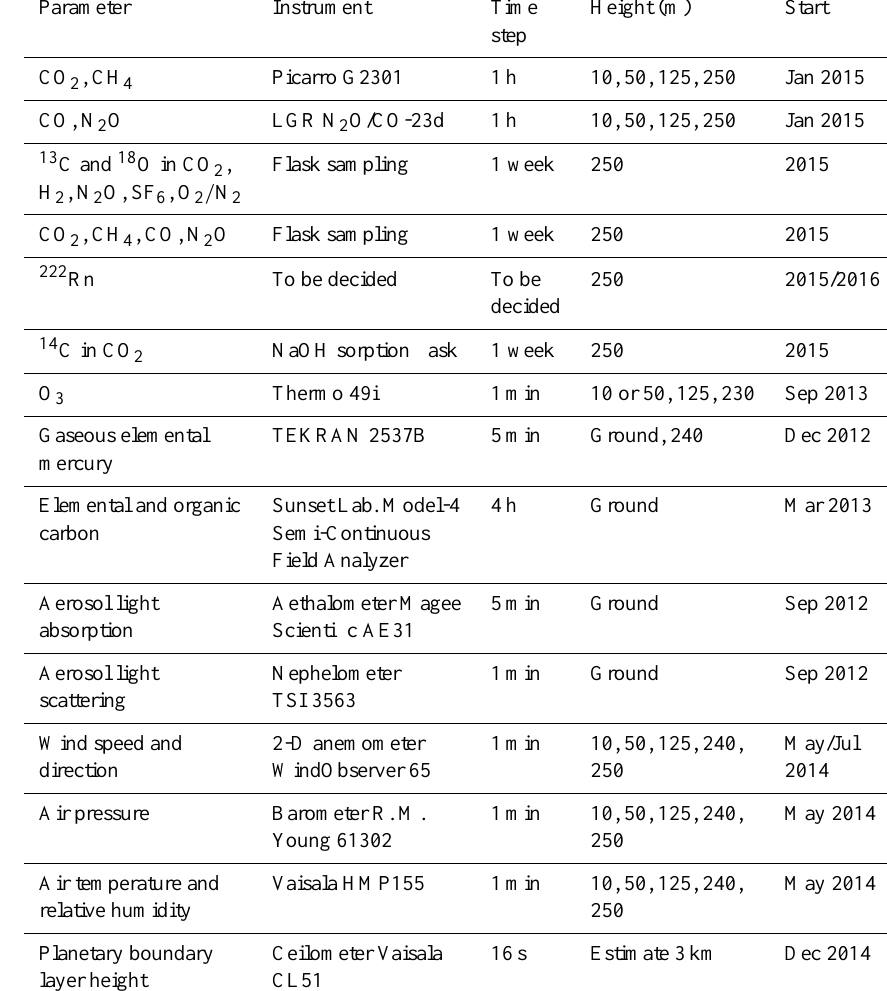
Table 1. Basic set of parameters measured at the Atmospheric Station Kˇrešín u Pacova.